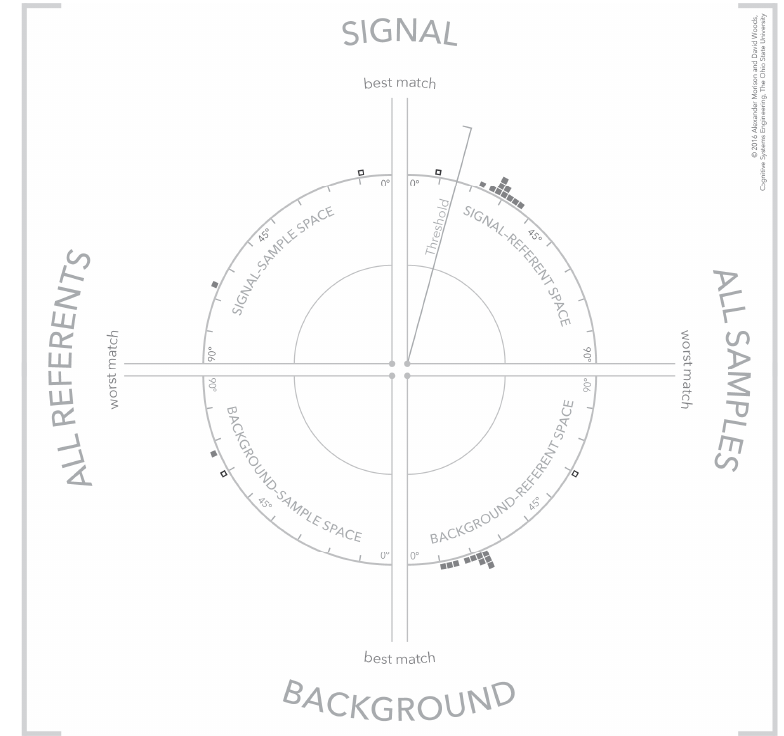
Figure 9. The visualization illustrating a strong signal detection where the selected sample is a strong match to a signal referent and a poor match to all available background referents. The background quadrants that form the bottom half of the visualization are parameterized to leverage the same visual landmarks as described in the top half of the visualization. All four quadrants use the same angular parameterization with the same range, however, for the background referent quadrants the origin and direction of increasing value are transformed to provide a consistent visual pattern. The origin for these two quadrants is along the downward vertical axis. Visually, this makes the vertical position of the visualization the area where strong matches occur. magnitude for the lower right quadrant is counter-clockwise and for the lower-left quadrant is clockwise. Visually, this makes the horizontal axis for the visualization the position for poor matches. The organization of different origin points and directions of increasing magnitude is a key